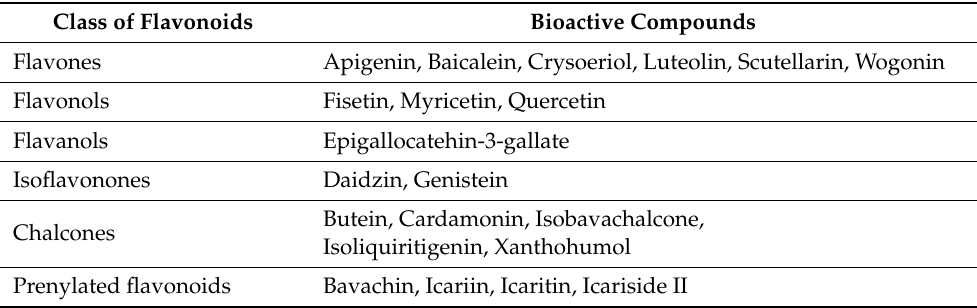
Table 1. Flavonoids involved in the management of multiple myeloma. Class of